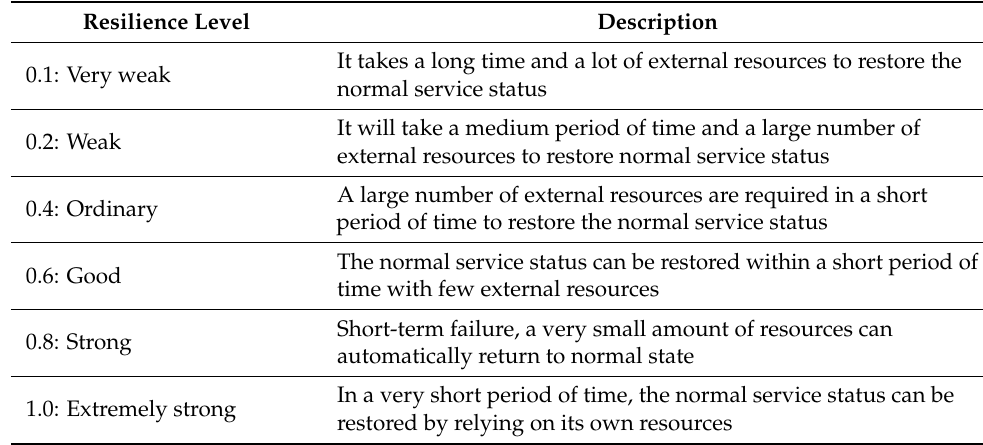
Table 4. Disaster resilience assessment instruction